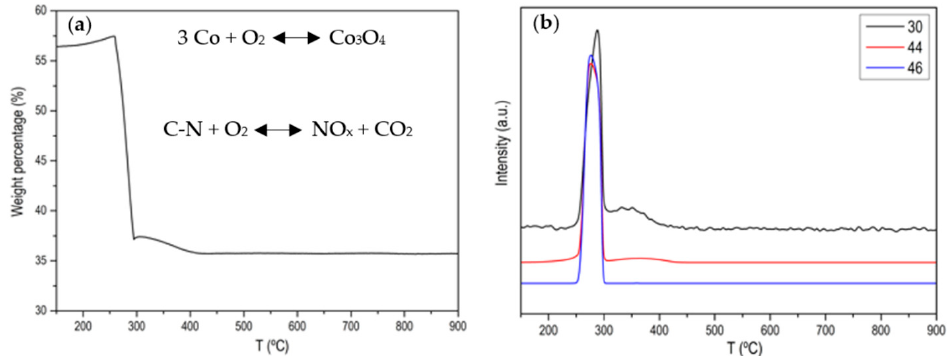
Figure 1. ( a ) Normalized TG profile of ZIF-67 in Ar atmosphere; ( b ) MS signal for m/z 28 (N 2 ), m/z 54 and m/z 82 (main 2-Methylimidazole fragmentations).